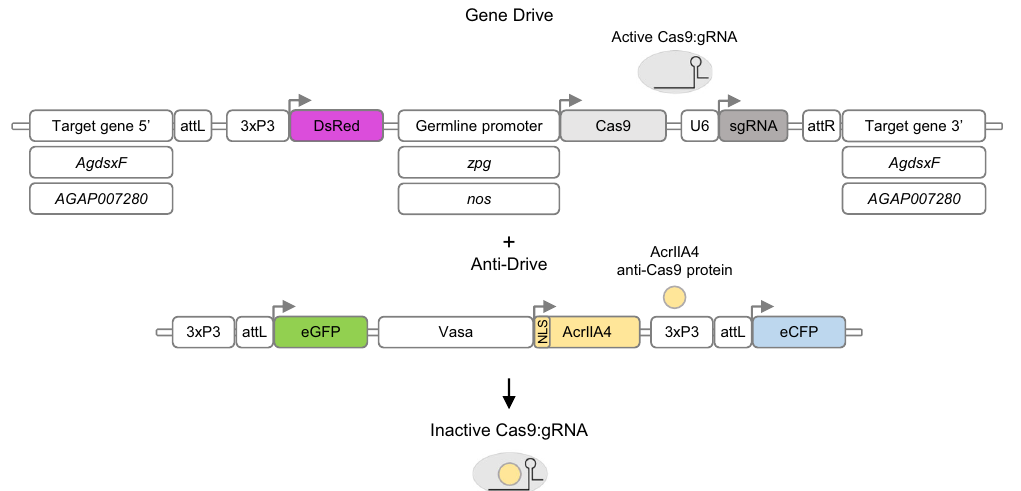
Fig. 1 Schematic representation of gene drive and anti-drive constructs. Gene drive and anti-drive constructs respectively as inserted in the genome of the gene drive lines previously generated (zpg:dsxF 2 ; zpg:7280 and nos:7280, ref. 26 ) and the newly generated anti-drive (vasa:A4) line. Speci fi cally, the gene drive constructs tested in this work are inserted at target sites within the AGAP007280 or AgdsxF ( AGAP004050-RB ) gene-coding sequences and contain: the Streptococcus pyogenes Cas9 nuclease (Cas9), under the transcriptional control of the male and female germline-speci fi c promoters zpg or nos ; the gRNA, targeting the respective insertion site, transcribed by the RNA polymerase III responsive promoter ( U6 ), and the DsRed fl uorescent protein under the 3xP3 promoter (3xP3:DsRed) for the identi fi cation of larvae carrying the drive. The anti-drive construct carries the Listeria monocytogenes anti- CRISPR protein (AcrIIA4) expressed under the vasa male and female germline-speci fi c promoter with the N-terminus addition of a nuclear localisation signal (NLS) and the eGFP fl uorescent protein under the 3xP3 promoter (3xP3:eGFP) used for the screening of anti-drive positive larvae. The construct was inserted in a pre-existing docking line carrying the 3xP3:eCFP marker 25 . As a result the AcrIIA4 protein is expected to interact and inhibit the Cas9 – gRNA complex, when co-expressed in the mosquito germline